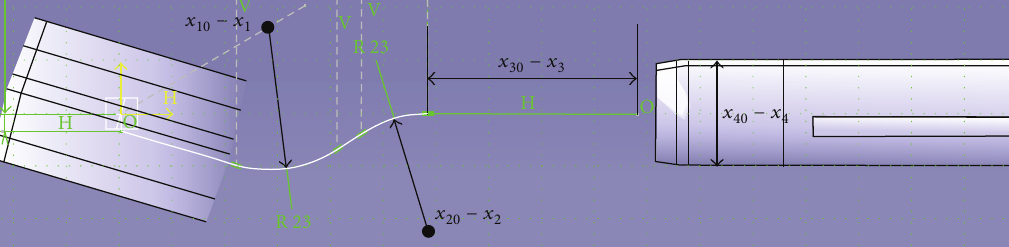
Figure 4: Shape design variables.